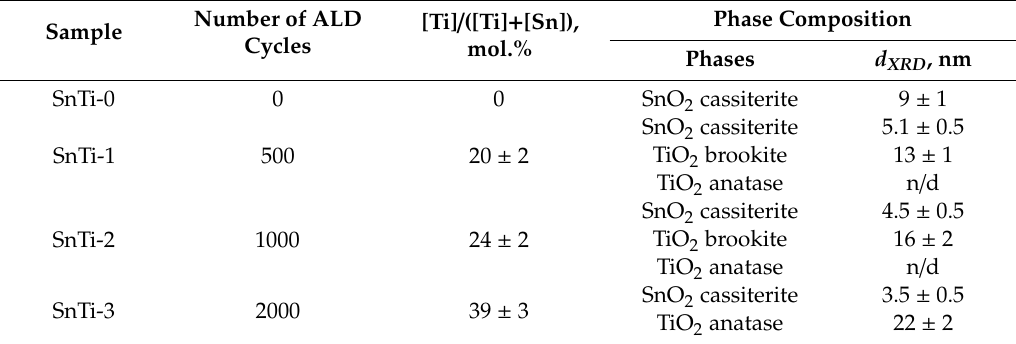
Table 1. Elemental and phase composition of SnO 2 reference sample and TiO 2 @SnO 2 nanocomposites with crystallite size d XRD of detected phases.